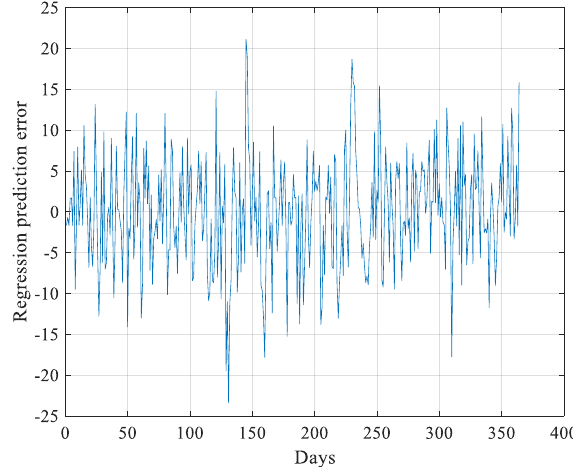
Figure 11. Regression prediction error chart of original signal .